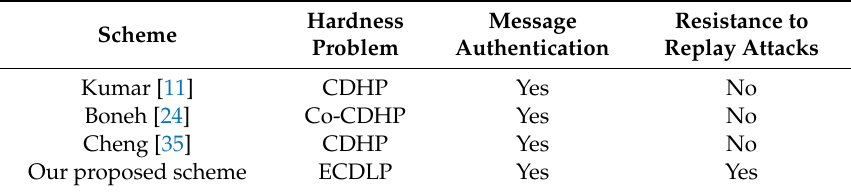
Table 3. The security comparison of relevant aggregate